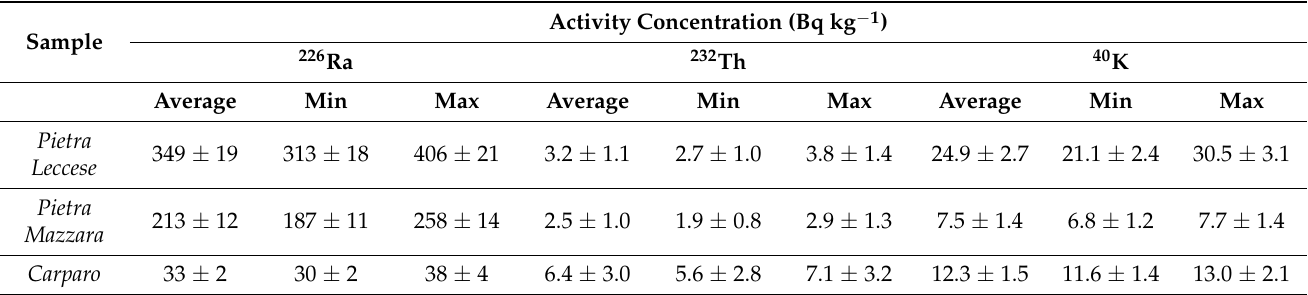
Table 2. Average, minimum and maximum values of activity concentration of natural radionuclides in the analyzed samples. Sample